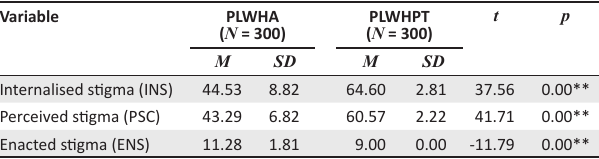
TABLE 2: Independent sample t -tests on stigma dimensions between study